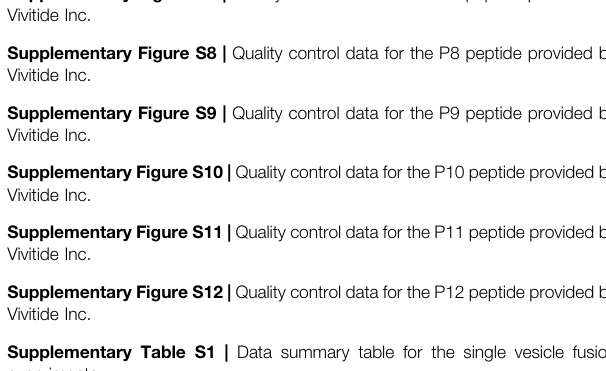
Supplementary Figure S1 | Quality control data for the P0 peptide provided by Vivitide Inc. Supplementary Figure S2 | Quality control data for the P1 peptide provided by Vivitide Inc. Supplementary Figure S3 | Quality control data for the P2 peptide provided by Vivitide Inc. Supplementary Figure S4 | Quality control data for the P3 peptide provided by Vivitide Inc. Supplementary Figure S5 | Quality control data for the P4 peptide provided by Vivitide Inc. Quality control data for the P5 peptide provided by Vivitide Inc. Supplementary Figure S6 | Quality control data for the P6 peptide provided by Vivitide Inc. Supplementary Figure S7 | Quality control data for the P7 peptide provided by Vivitide Inc. Supplementary Figure S8 | Quality control data for the P8 peptide provided by Vivitide Inc. Supplementary Figure S9 | Quality control data for the P9 peptide provided by Vivitide Inc. Supplementary Figure S10 | Quality control data for the P10 peptide provided by Vivitide Inc. Supplementary Figure S11 | Quality control data for the P11 peptide provided by Vivitide Inc. Supplementary Figure S12 | Quality control data for the P12 peptide provided by Vivitide Inc. Supplementary Table S1 | Data summary table for the single vesicle fusion